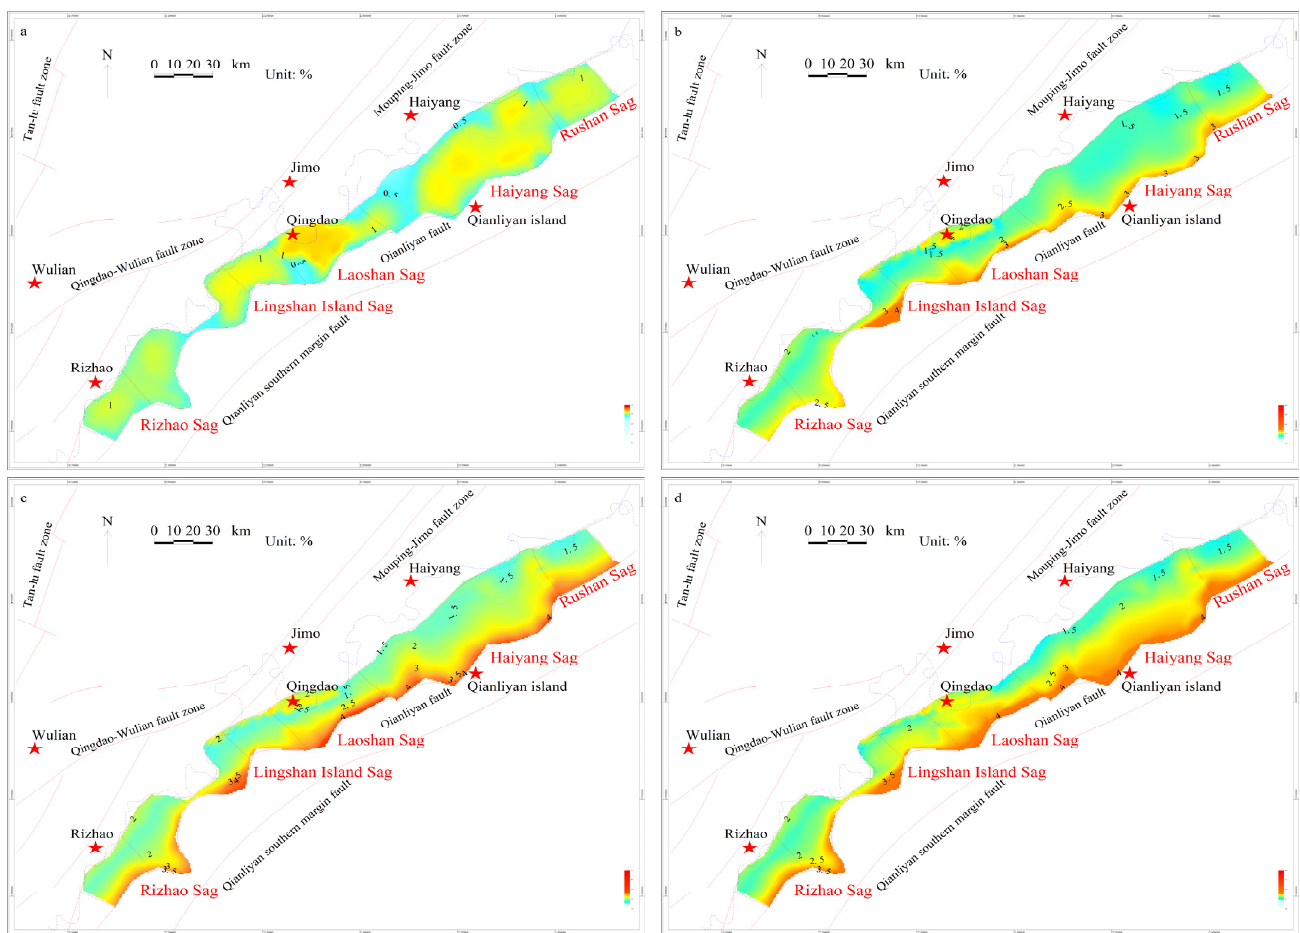
Figure 6. Contour map of R o in different periods in the Ri-Qing-Wei Basin (( a ). R o contour at the end of the Laiyang period; ( b ). R o contour at the end of the Qingshan period; ( c ). R o contour at the end of the Wangshi period; ( d ). present-day R o contours).